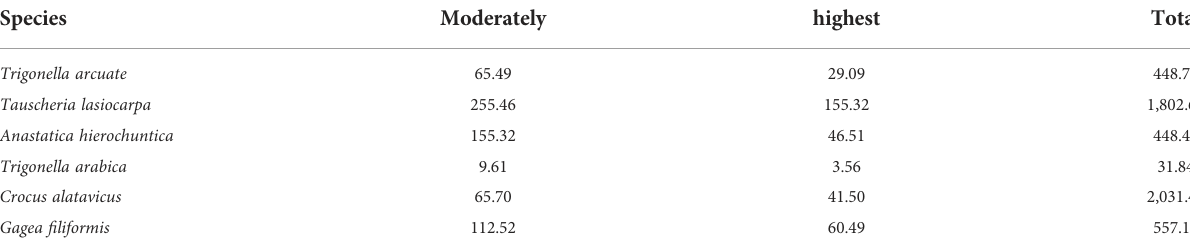
TABLE 7 Current potential suitable distribution area of six ephemeral plants (×10 4 km 2